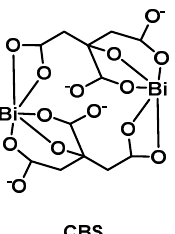
Figure 3. Structure of colloidal bismuth subcitrate ( CBS